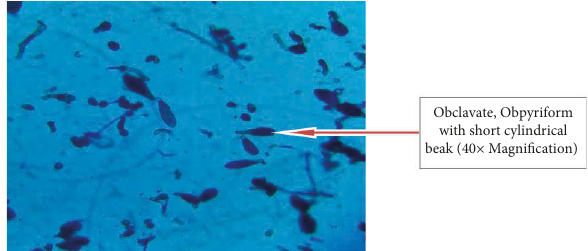
Figure 5: Alternaria spp (macroconidia: Obclavate, obpyriform, often with short conical or cylindrical beak, pale brown) in LPCB